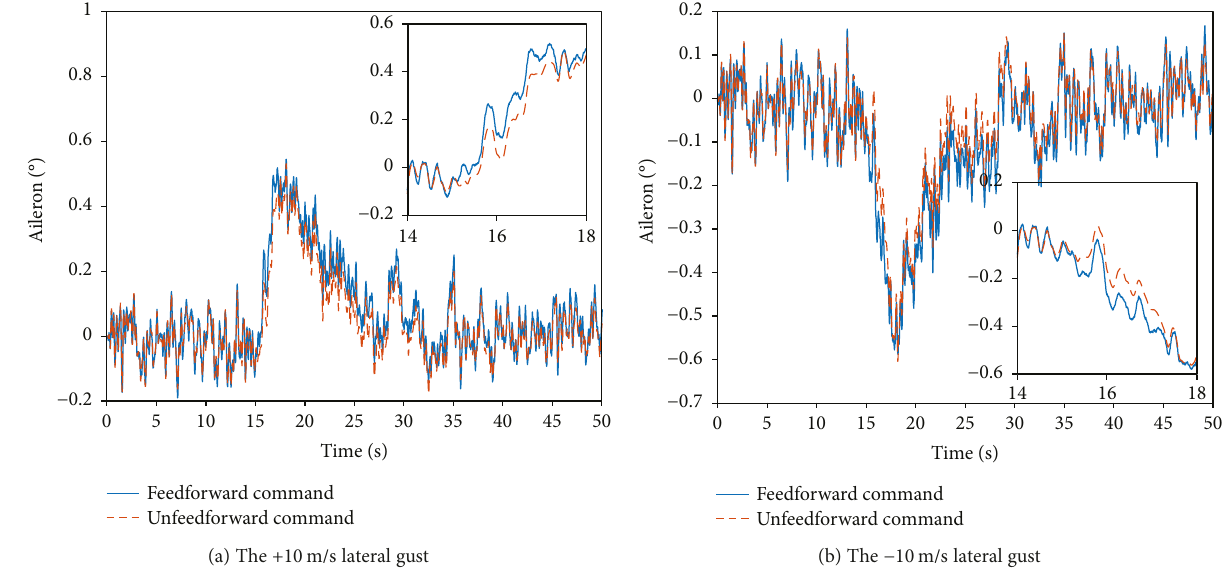
Figure 9: The control